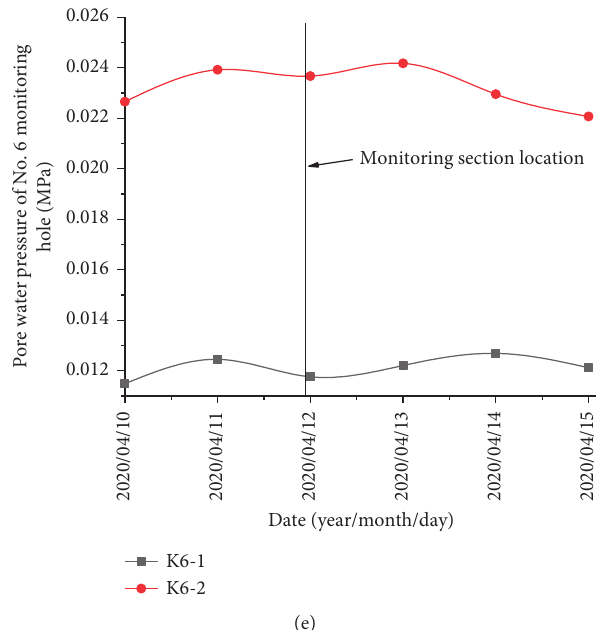
Figure 14: Variation diagram of pore water pressure during Hole 2 jacking. (a) Pore water pressure of No. 2 monitoring hole. (b) Pore water pressure of No. 3 monitoring hole. (c) Pore water pressure of No. 4 monitoring hole. (d) Pore water pressure of No. 5 monitoring hole. (e) Pore water pressure of No. 6 monitoring hole.